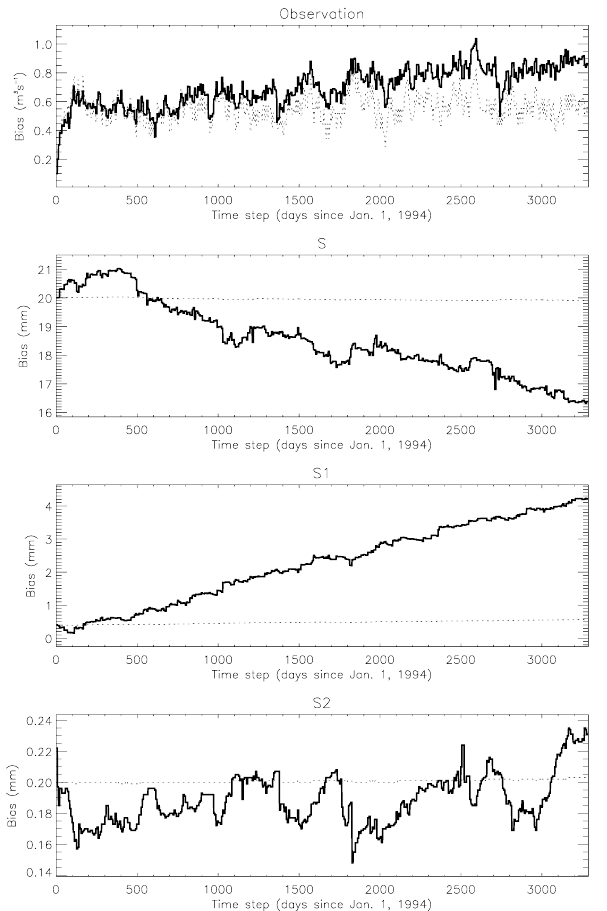
Fig. 4. Evolution of the estimated biases (the type of bias is indi- cated at the top of each plot) for experiment 2 using a multiplica- tion factor ( κ ) of 10 (solid lines) and 100 (dotted lines) to calcu- late the observation bias error covariance. The top panel indicates the observation bias, and the second, third, and bottom panels indi- cate the bias in the soil, groundwater, and surface runoff storages, respectively.